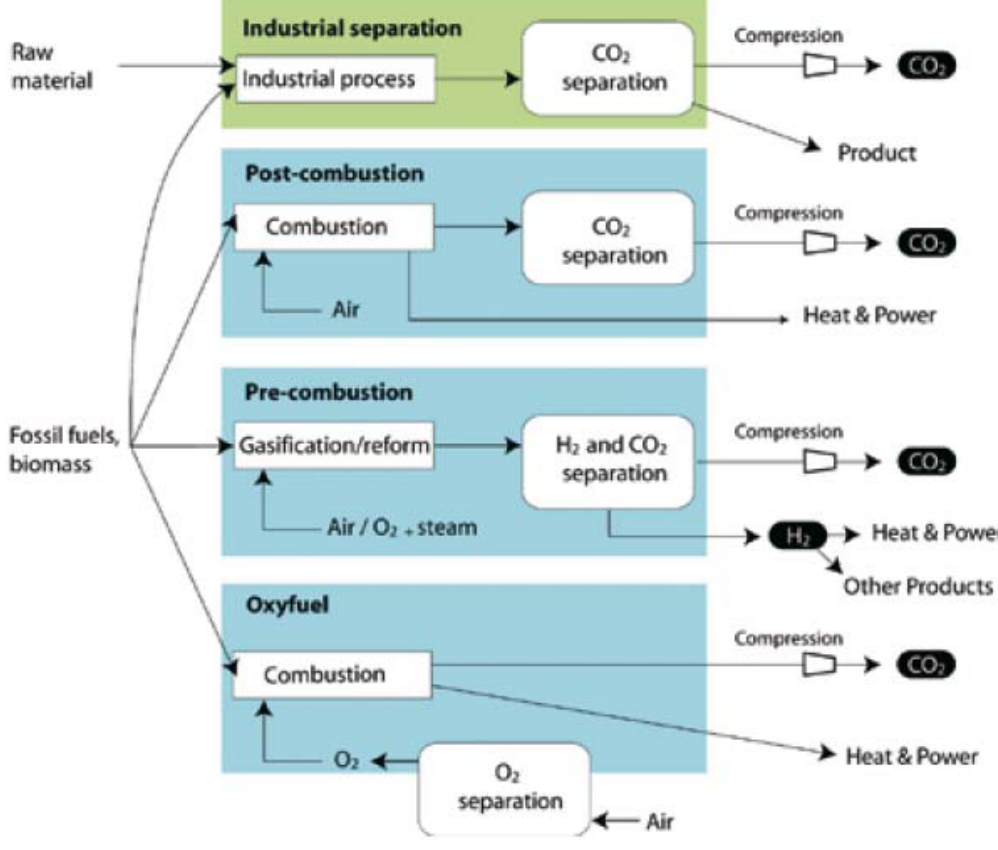
Figure 10. Schematic representation of methods for carbon capture (after